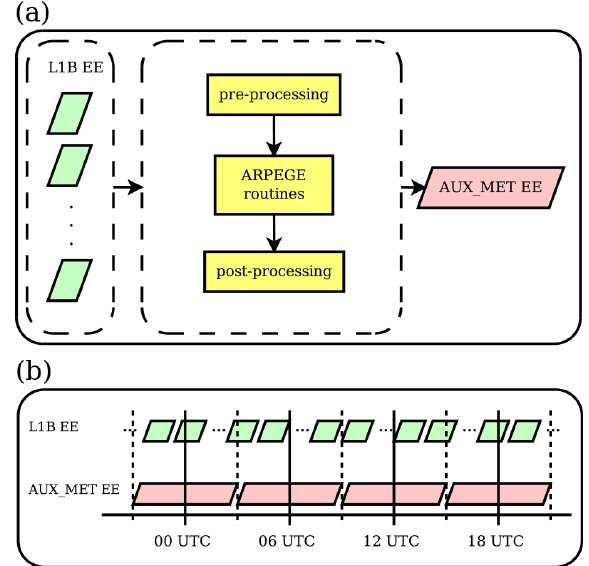
Figure 1. Production of AUX_MET files at Météo-France. A de- tailed description is given in Sect. 3. The EE stands for Earth Ex- plorer file